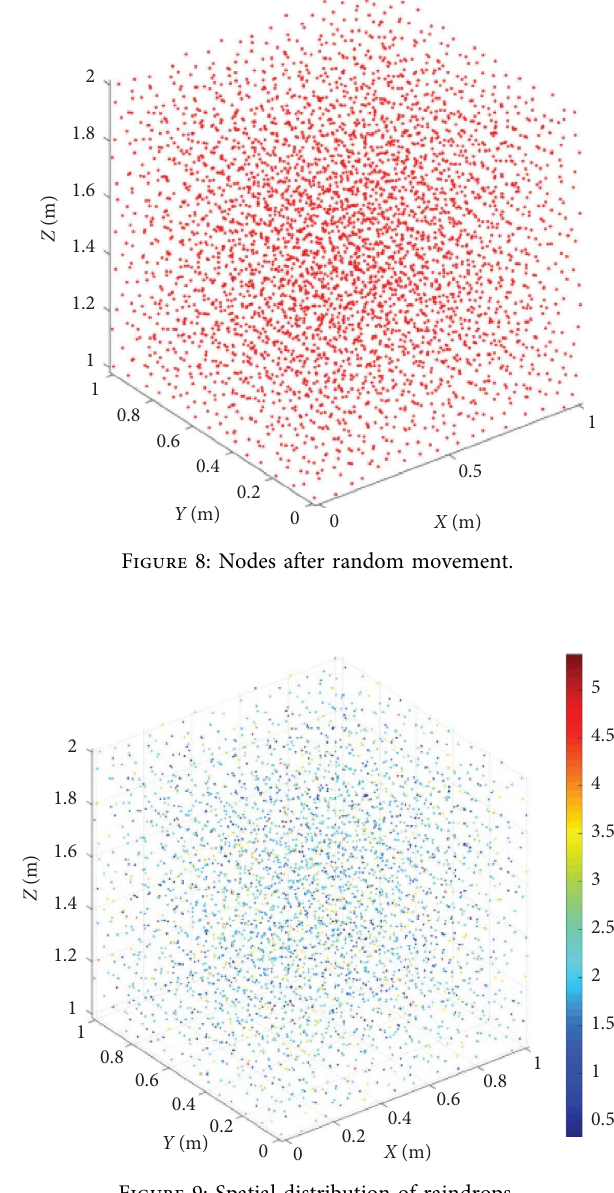
Figure 9: Spatial distribution of raindrops.